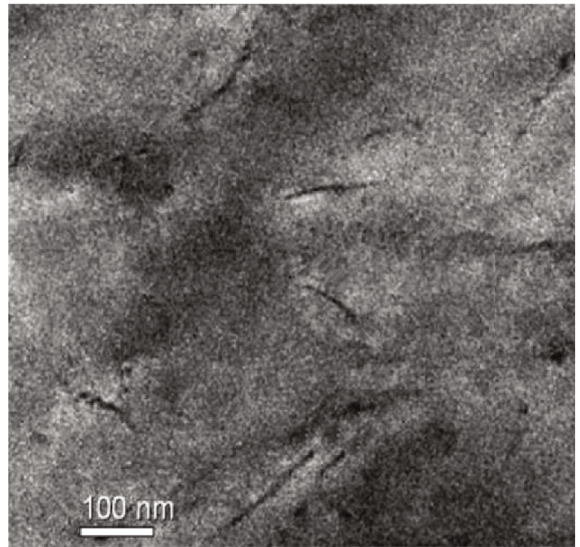
Figure 1: TEM image of GE/NR nanocomposites with GE loading 1